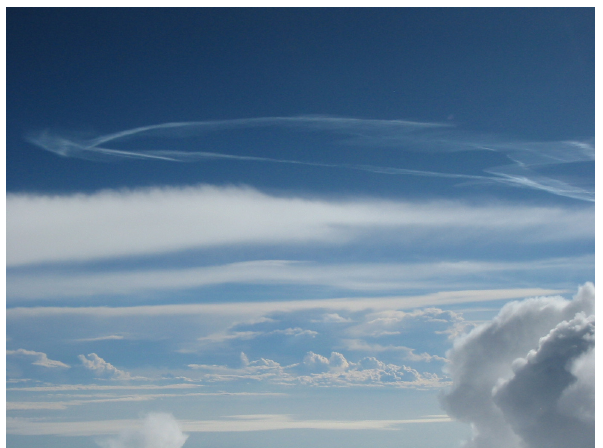
Figure 1. Geophysica contrail photo from the DLR Falcon at 130.0 ◦ E, 11.8 ◦ S, 08:35UTC (18:05LT) 16 November